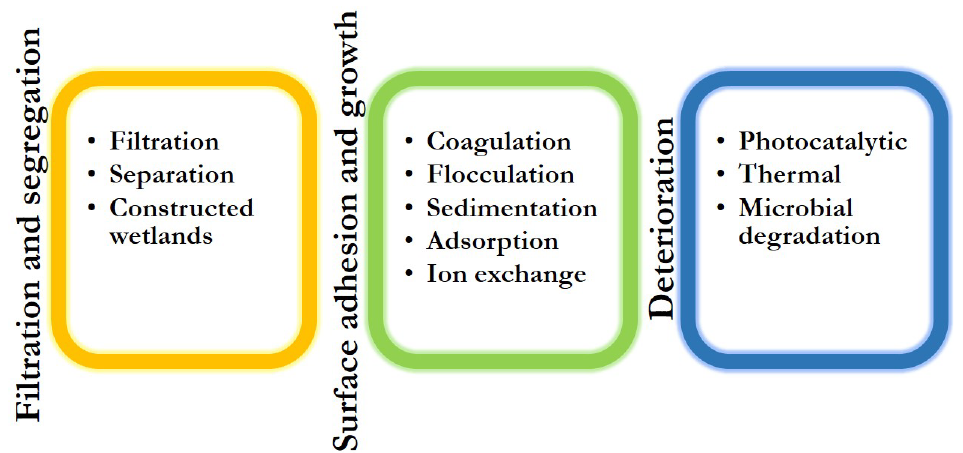
Figure 5. Classification of methods used for the removal of microplastics from aqueous media [41– 46].